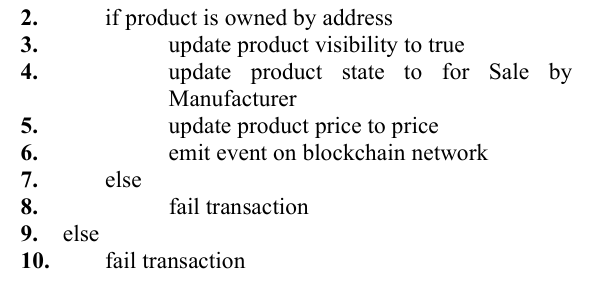
Algorithm 1: Create product by Manufacturer